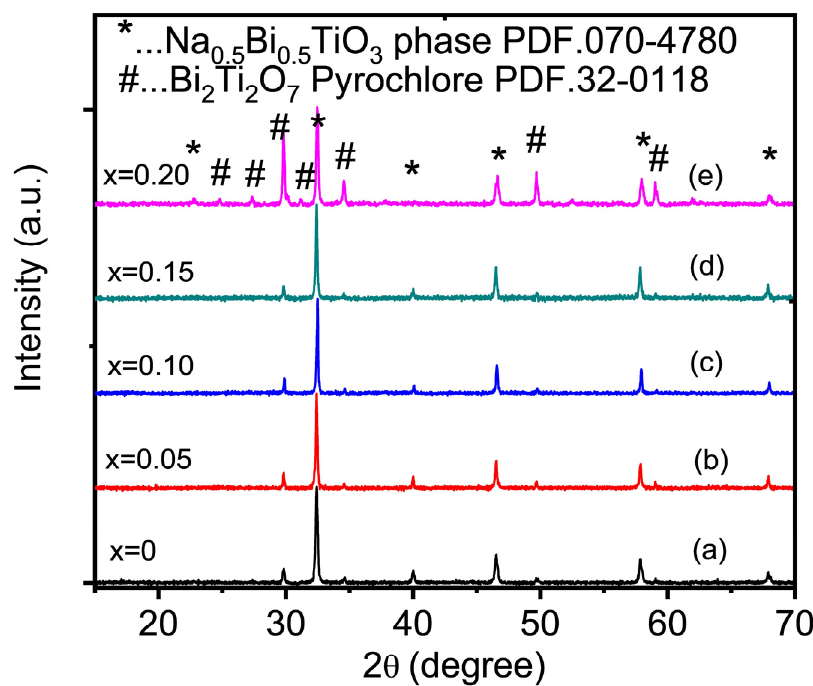
Figure 1. PXRD pa tt erns of (NBT-BT-NBN 1 − x T x ) ceramic compositions: ( a ) x = 0.00; ( b ) x = 0.05; ( c ) x = 0.10; ( d ) x = 0.15; ( e ) x = 0.20.